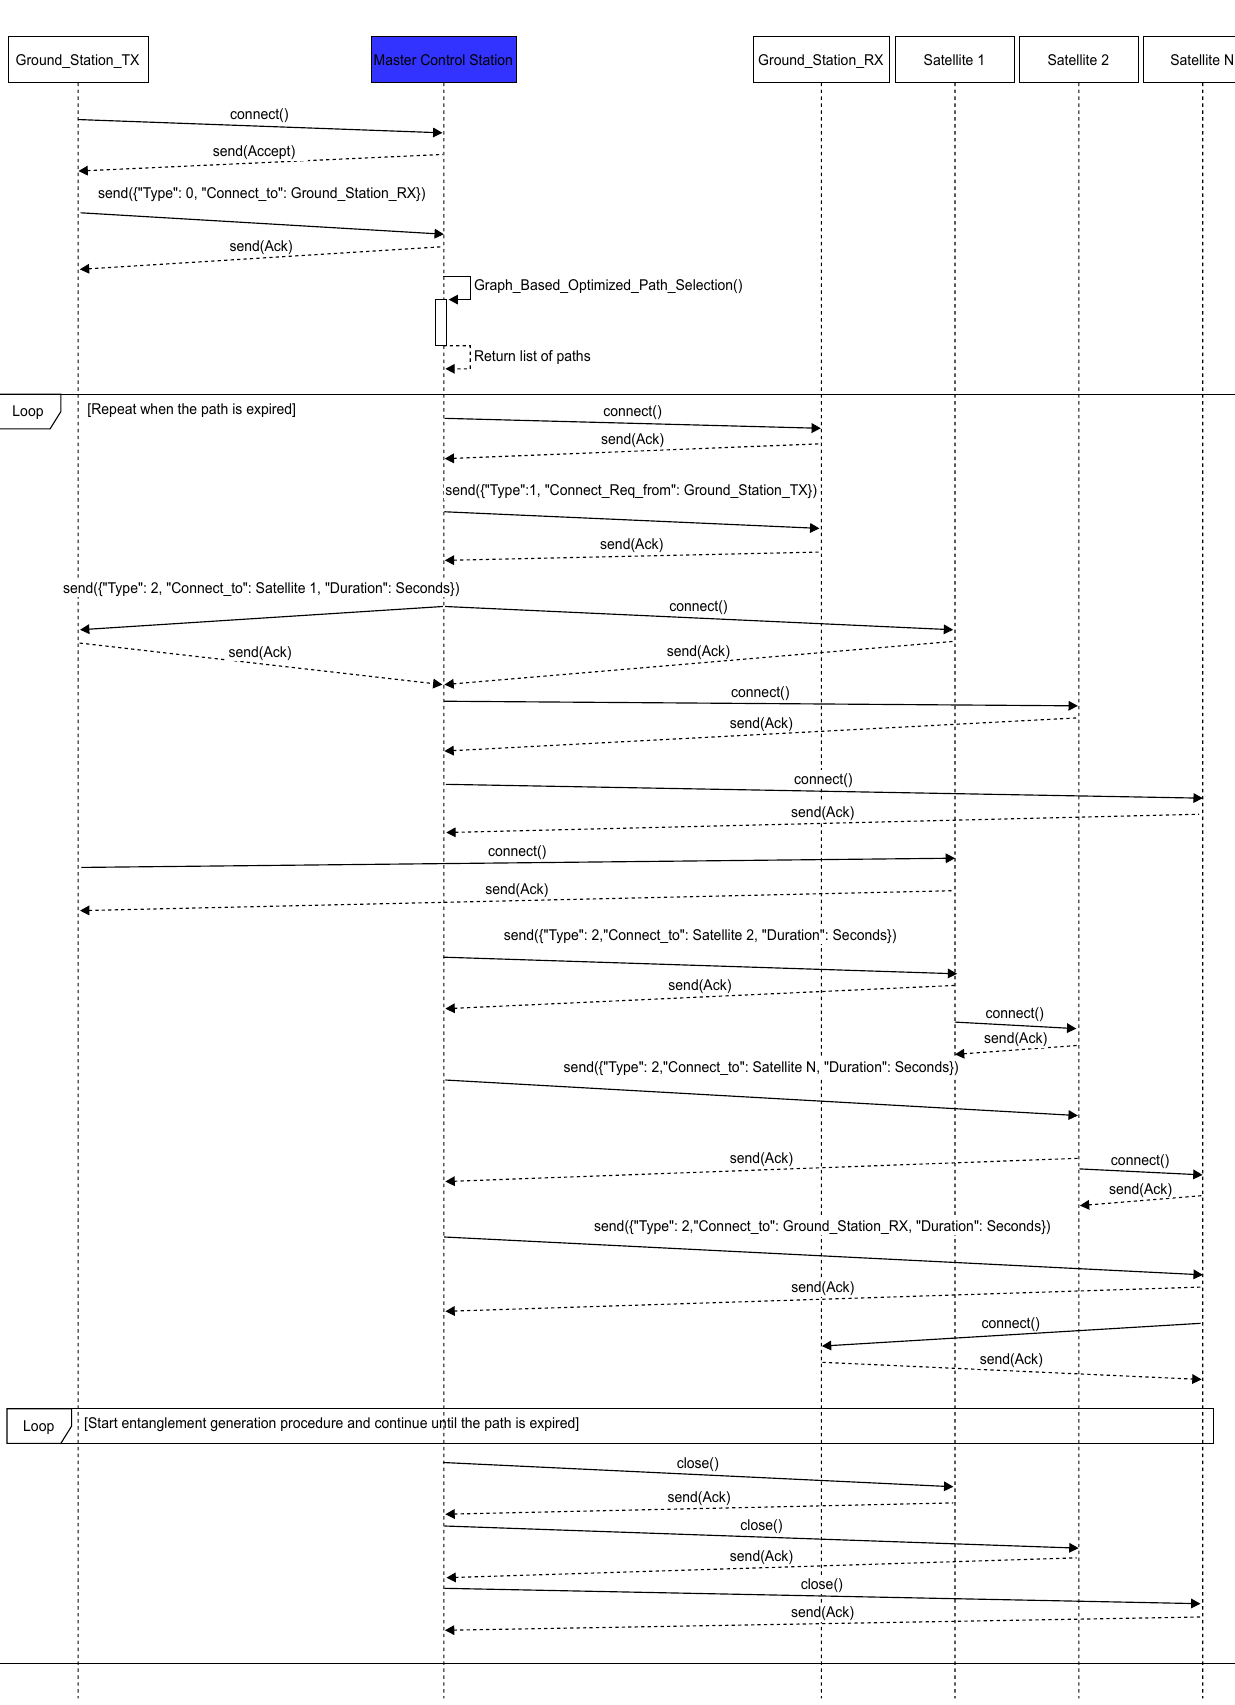
Figure 4. Sequence diagram of the first phase of the protocol. The MCS performs the setup operations on the selected